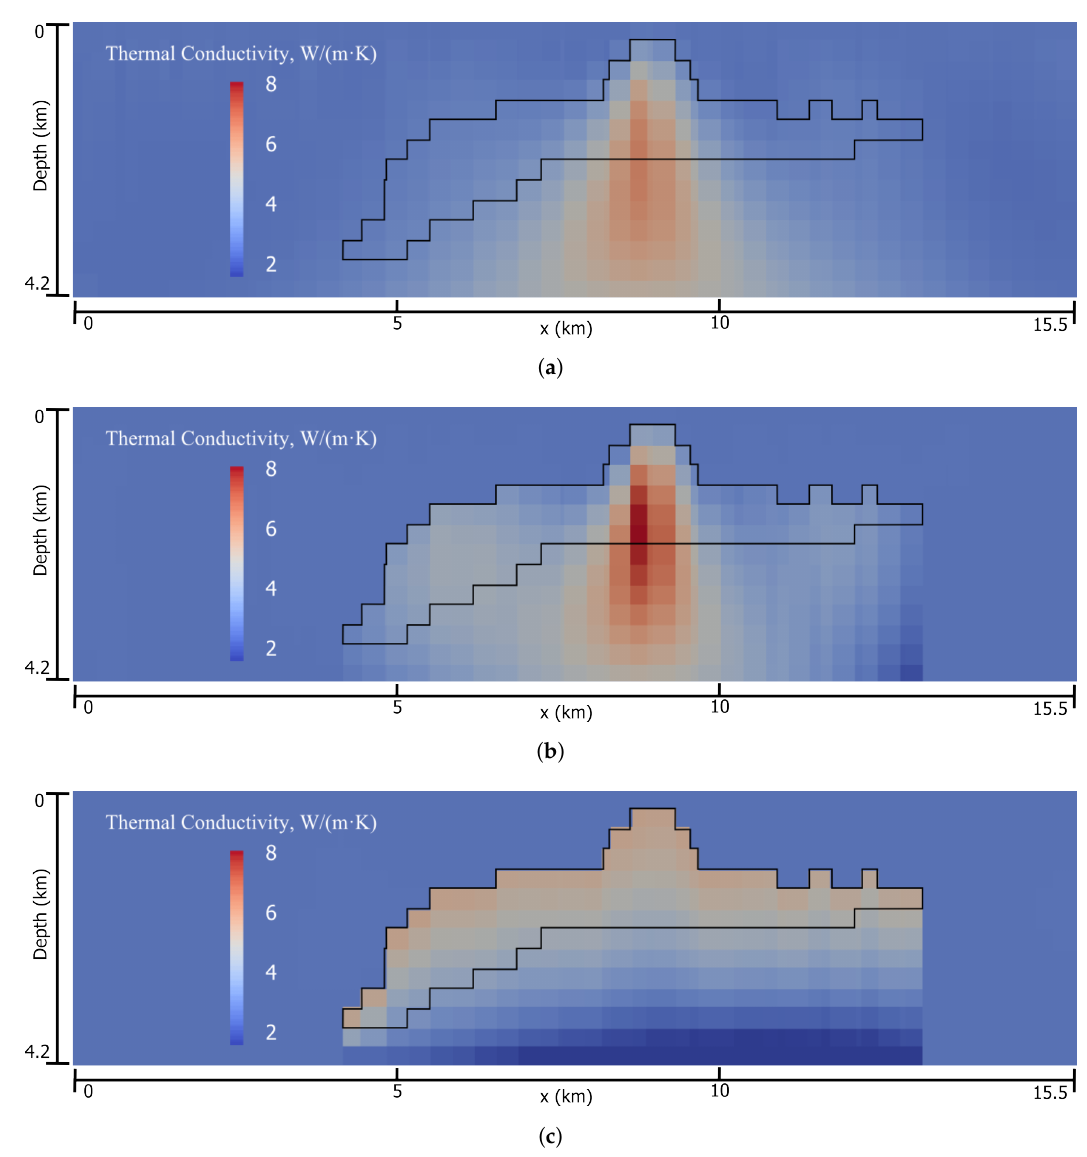
Figure 6. ( a ) Cross-section, excluding padding cells, of an inversion result constraining only padding cells. The depth to the top of the anomaly and the maximum thermal conductivity are similar to the true model but the structure of the salt body is not well-defined. ( b ) Cross-section, excluding padding cells, of the result of inversion constraining all cells above and outside the salt body. The horizontal extent of the body is better defined and the maximum conductivity value is higher than in the true model. The base of the salt is still not defined. ( c ) Cross-section, excluding padding cells, of an inversion result using a reference model built from the top of the salt. By incorporating the expected value of the conductivity of the salt body into the reference model, the base of the salt body is better